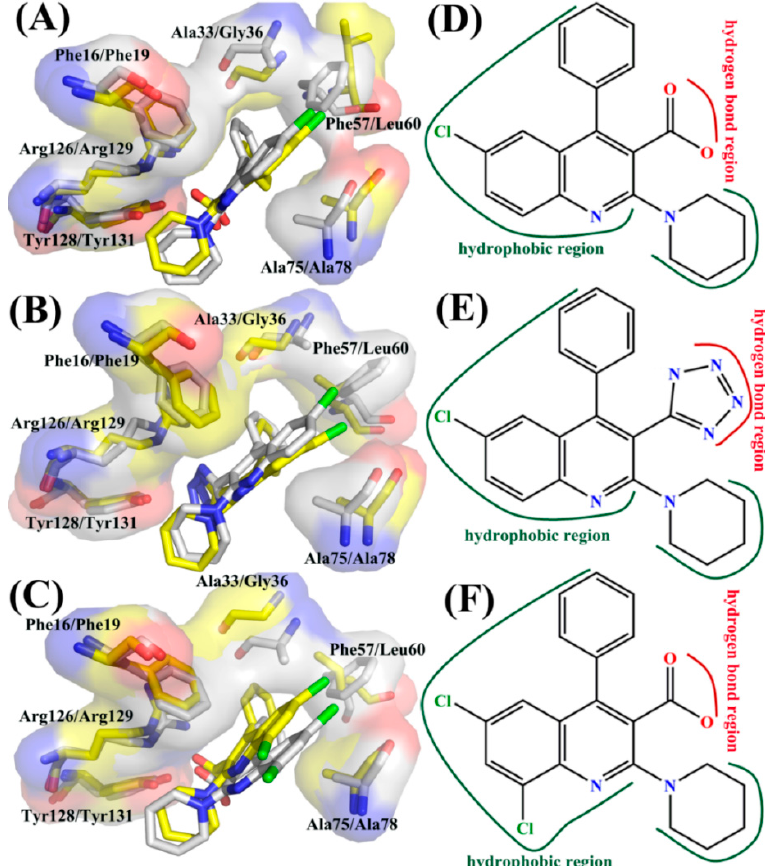
Figure 7. Superposition of specific active sites between structures of inhibitor-FABP4 complex and inhibitor-FABP5 complex: ( A ) 5M7-FABP4/FABP5; ( B ) 65X-FABP4/FABP5; and ( C ) 65Z-FABP4/FABP5. Inhibitors and key residues in inhibitor-FABP4 complexes are displayed with gray, while that in inhibitor-FABP5 complexes are displayed with yellow. The interaction models between FABP4/5 and three inhibitors: ( D ) 5M7; ( E ) 65X; and ( F ) 65Z.